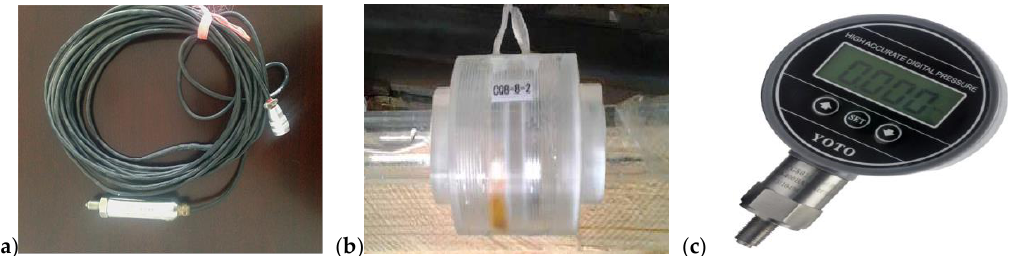
Figure 1. Layout of test devices: ( a ) pipeline on the positive slope, ( b ) pipeline on the flat slope, ( c ) pipeline on the reverse slope.